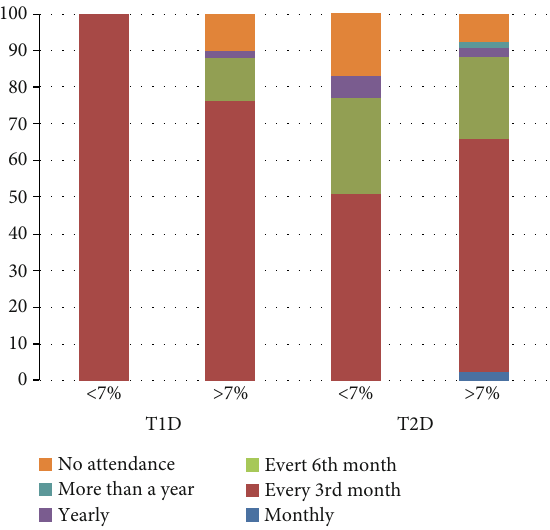
Figure 3: Attendance rate in the diabetology screening among those with normal or elevated HbA1c. T1D: type 1 diabetes mellitus; T2D: type 2 diabetes mellitus. ∗ Data presented are based upon the result of 1 individual in case of the T1D group having HbA1c <